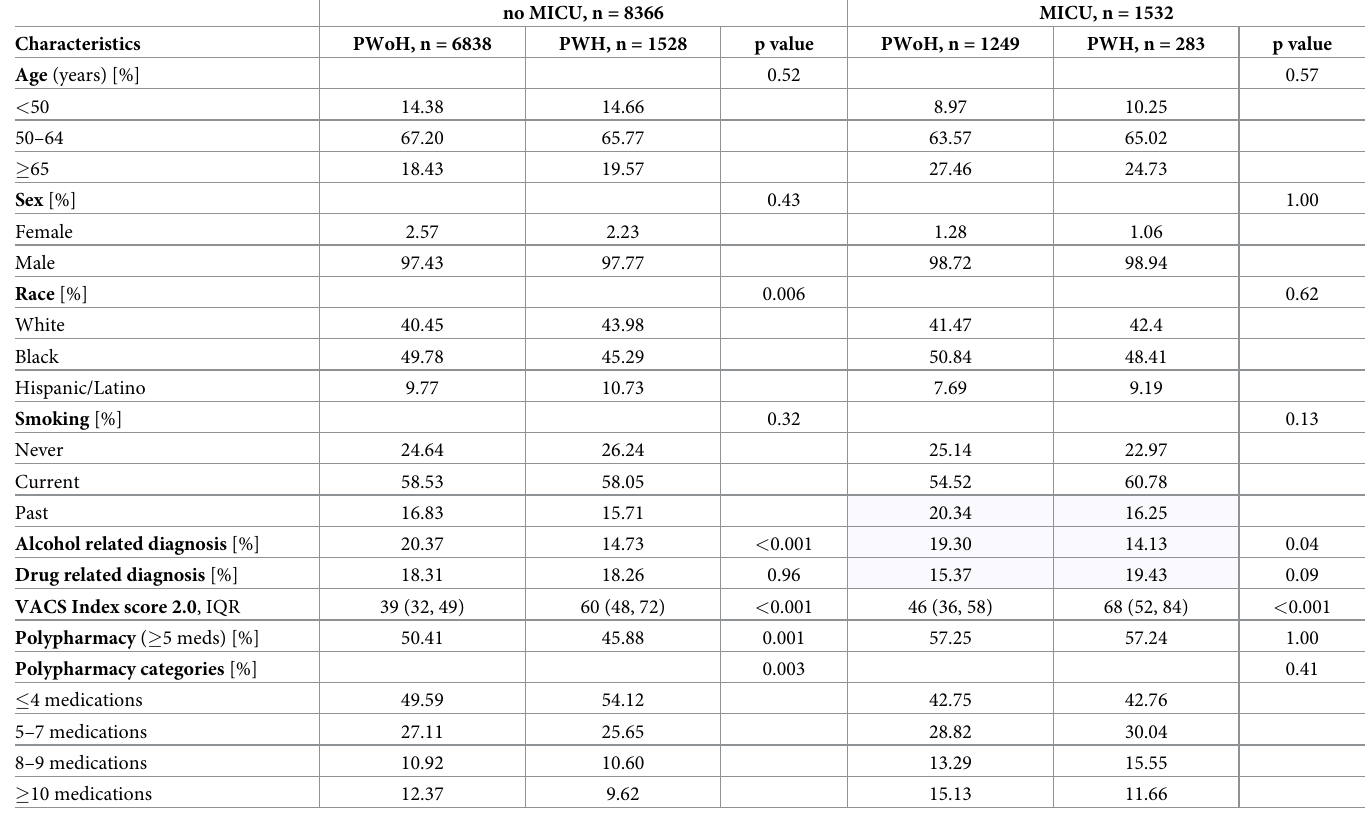
Table 1. Descriptive statistics of patient’s baseline characteristics by MICU admission and HIV